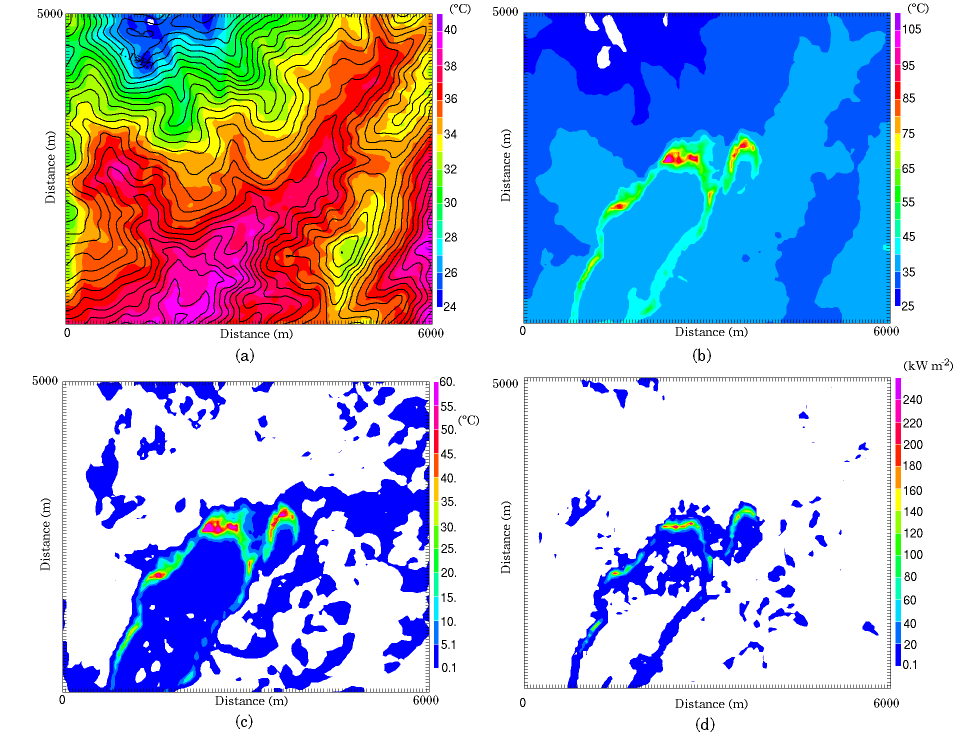
Figure 10. Horizontal cross-sections on 23 July 2009 at 1500 UTC: 2-m temperature (in deg Celsius) for the ( a ) “uncoupled”; ( b ) “coupled” and ( c ) the difference “coupled minus uncoupled”; ( d ) Sensible heat flux at a 20-m height for the difference “coupled minus uncoupled” (in kWm − 2 ). Isolines of orography are superimposed in ( a ).